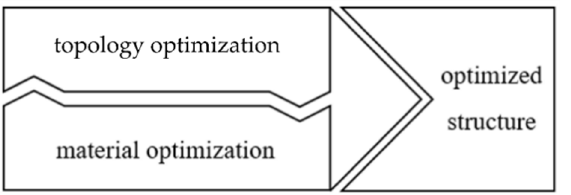
Figure 6 . The procedure of concurrent topology optimization considering the material orientation of anisotropic materials. In contrast to Figure 2, the topology and material optimization are not executed sequentially, but in every iteration a fiber-angle optimization is performed.